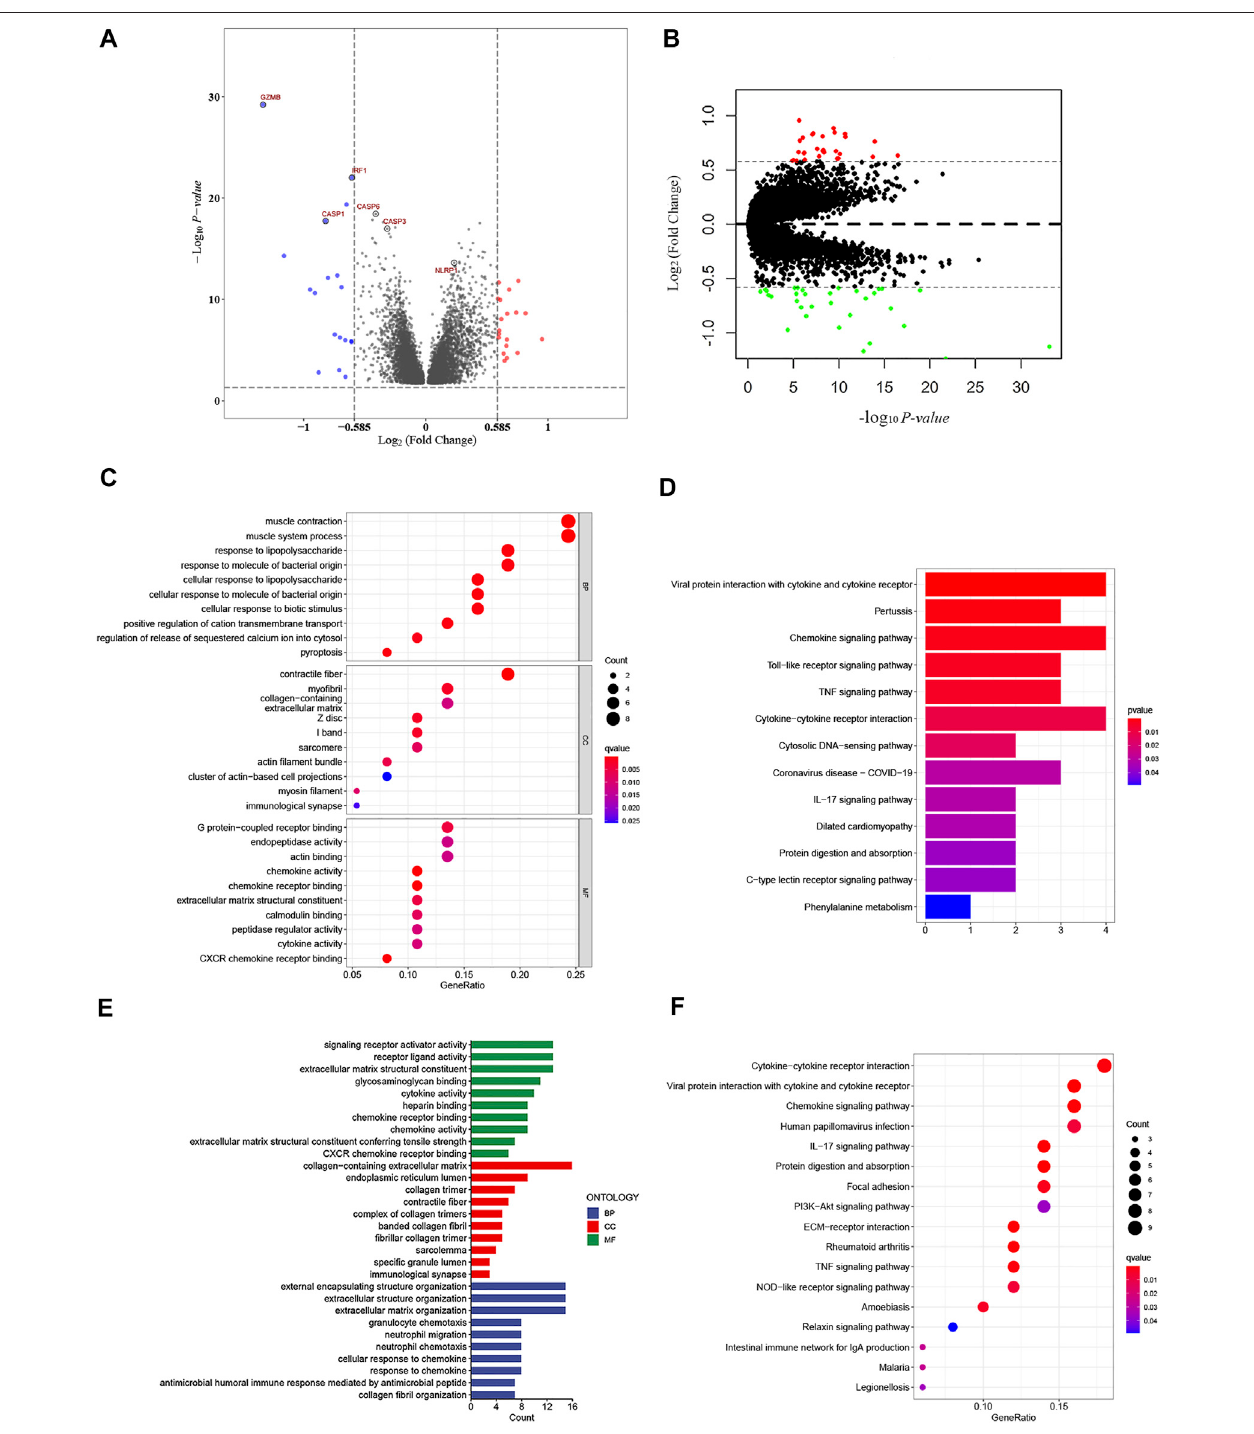
FIGURE 8 | Functional analysis based on the DEGs between the high- and low-risk groups. (A) Overview of the DEGs between the two-risk groups in the GSE39582 cohort (red represents upregulated genes, blue indicates downregulated genes, and gray represents no change, respectively). (B) Volcano fi gure of signi fi cant DEGs between the two-risk groups in the TCGA cohort (Red represents upregulated genes, green indicates downregulated genes, and gray represents no change,respectively). (C,D) Bubble graphforgeneontology(GO)analysisandthebarplot graphforKyoto EncylopediaofGenesand Genomes(KEGG)analysisin the GSE39582 cohort. (E,F) Barplot graph for gene ontology (GO) analysis and the bubble graph for Kyoto Encylopedia of Genes and Genomes (KEGG) analysis in TCGA cohort.